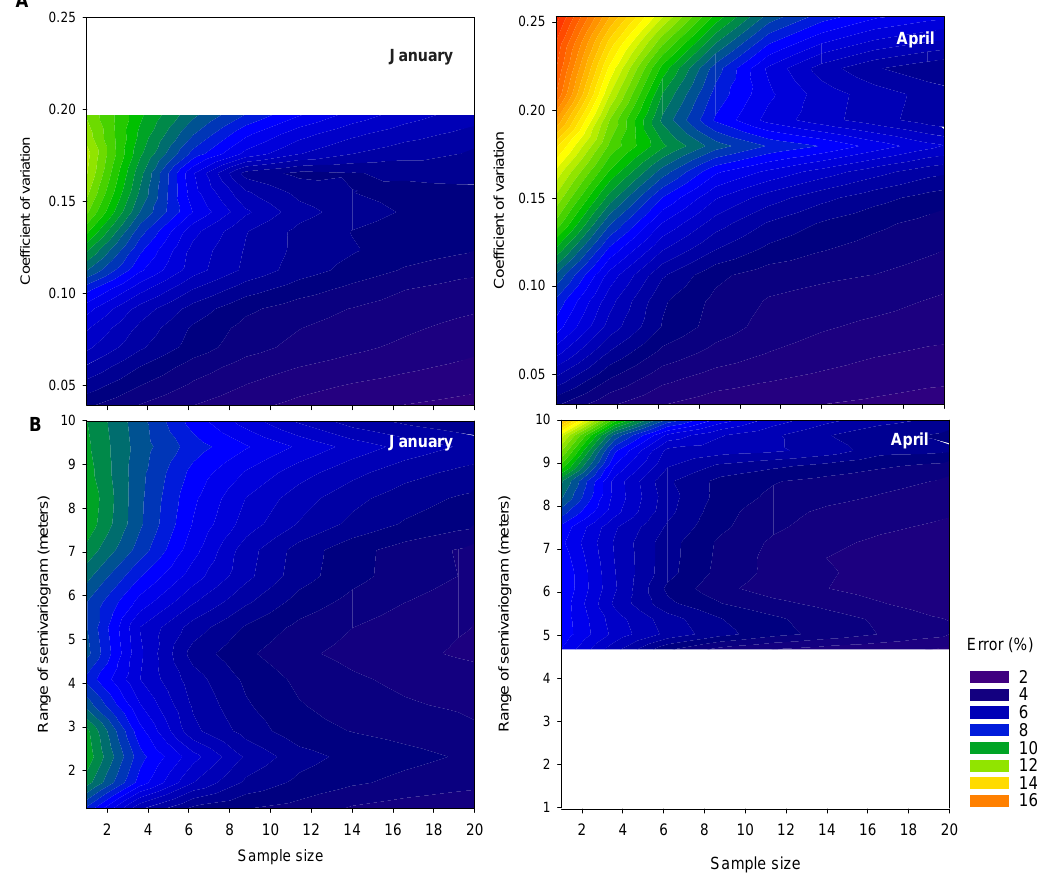
Fig. 5. Average error for various sample sizes according to (A) the coefficient of variation and (B) the spatial autocorrelation. The white areas correspond to ranges of the y-axis without data in one of the